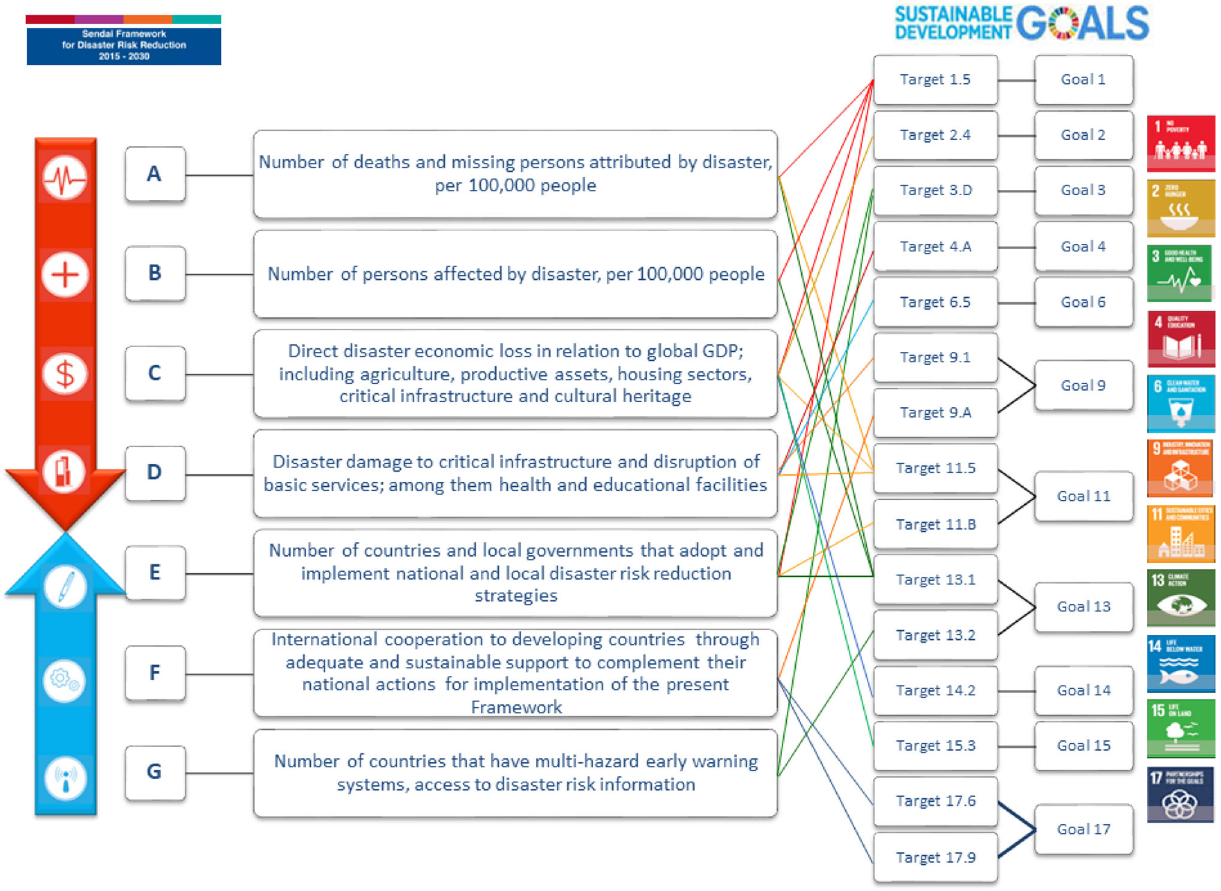
Fig. 1 Links between sendai framework targets and sustainable development